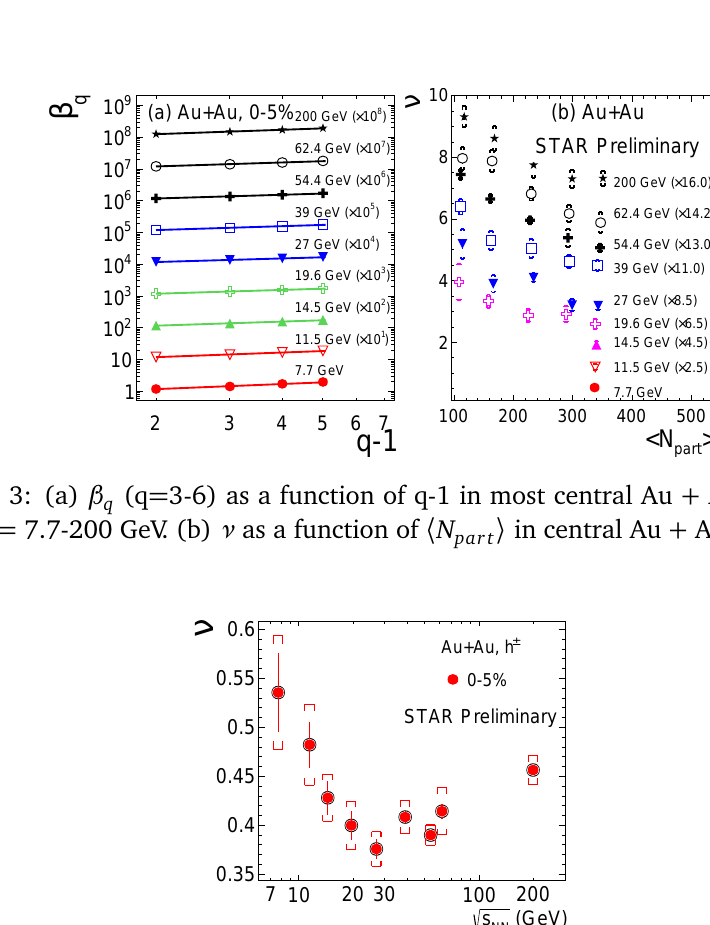
Figure 4: Energy dependence of ν for charged particles in Au + Au collisions at = 7.7- 200 GeV. The statistical and systematic errors are shown in bars and brackets,